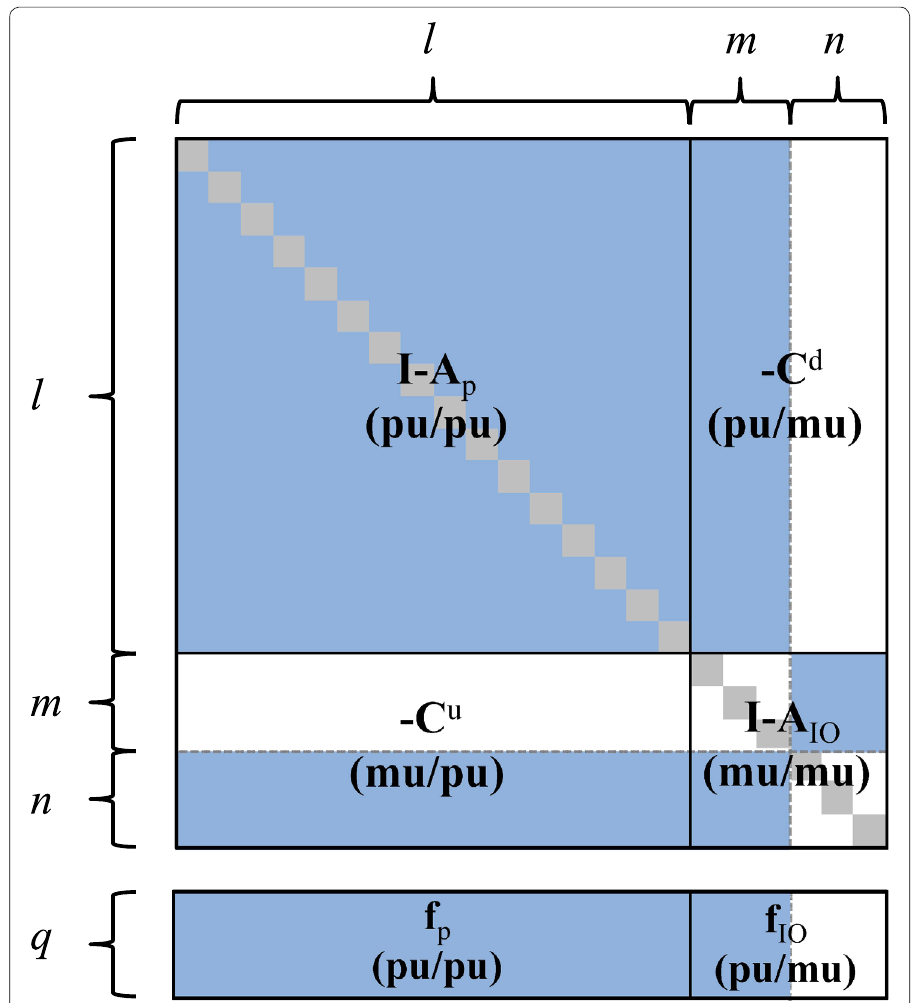
Fig. 3 Integrated coefficient matrix ( I A IH ) of integrated hybrid LCA (blue-shaded areas include nonzero − values, but may be sparsely populated; non-shaded areas contain zeroes; gray-shaded areas represent 1s on the diagonal; pu physical units; mu monetary